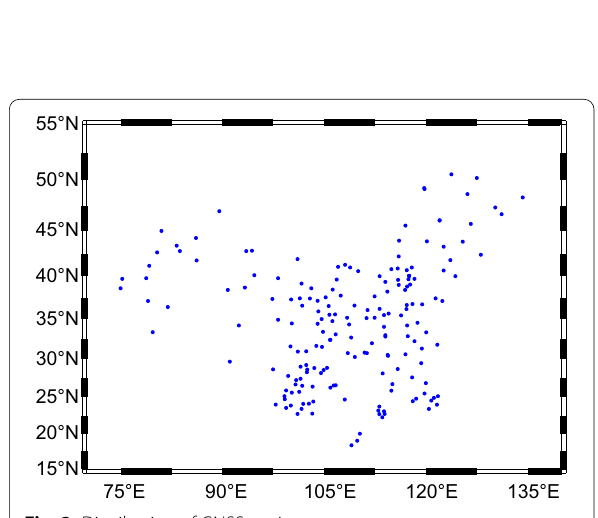
Fig. 2 Distribution of GNSS